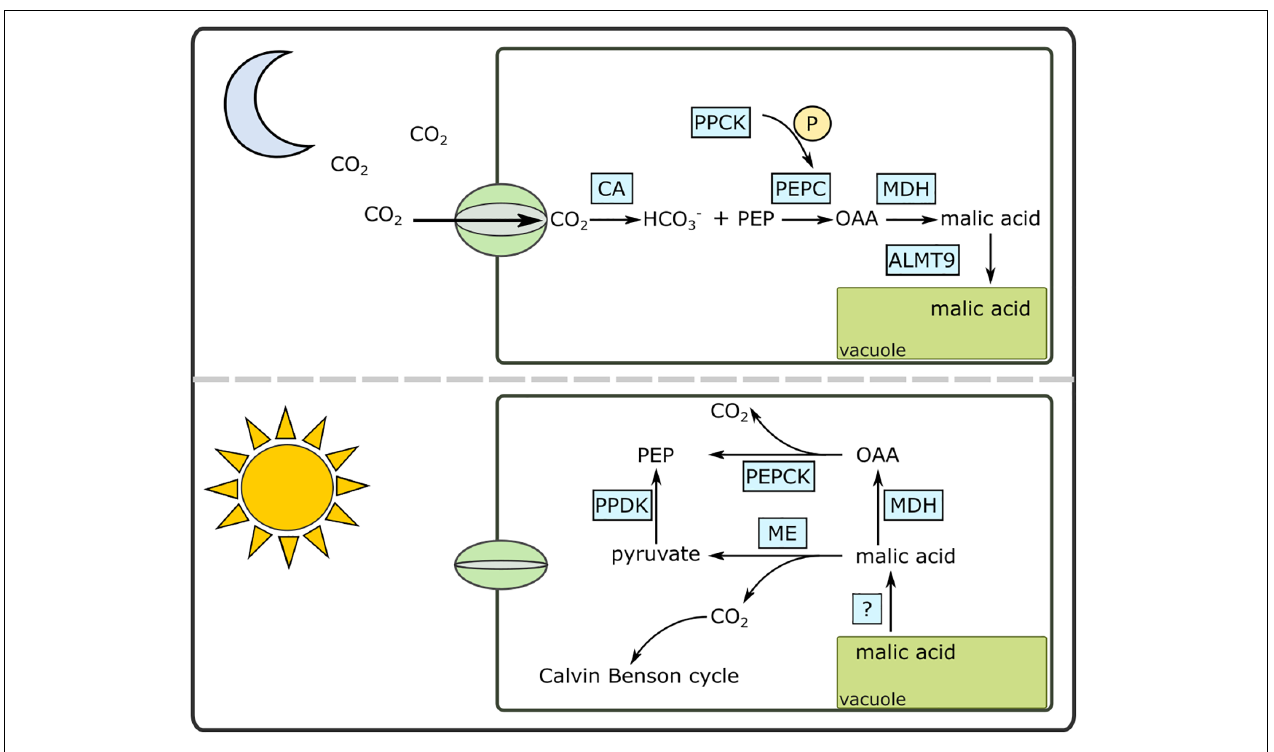
FIGURE 1 | A simplified diagram of the Crassulacean acid metabolism (CAM) pathway under day and night conditions. ALMT9, aluminum activated malate transporter; CA, carbonic anhydrase; MDH, malate dehydrogenase; OAA, oxaloacetate; ME, malic enzyme (NAD or NADP); P, phosphate; PEPC, phosphoenolpyruvate carboxylase; PEPCK, PEP carboxykinase; PPCK, PEPC kinase; PPDK, pyruvate, phosphate